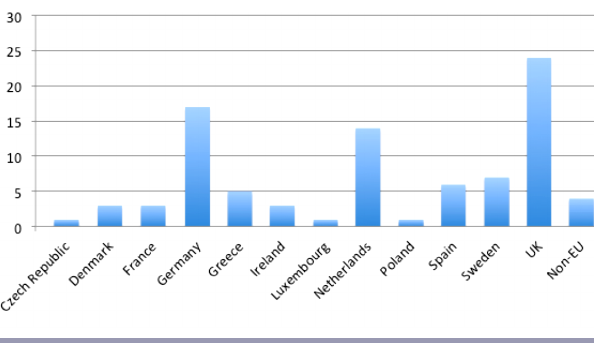
Fig. 2 . Number of publications by country of origin (first